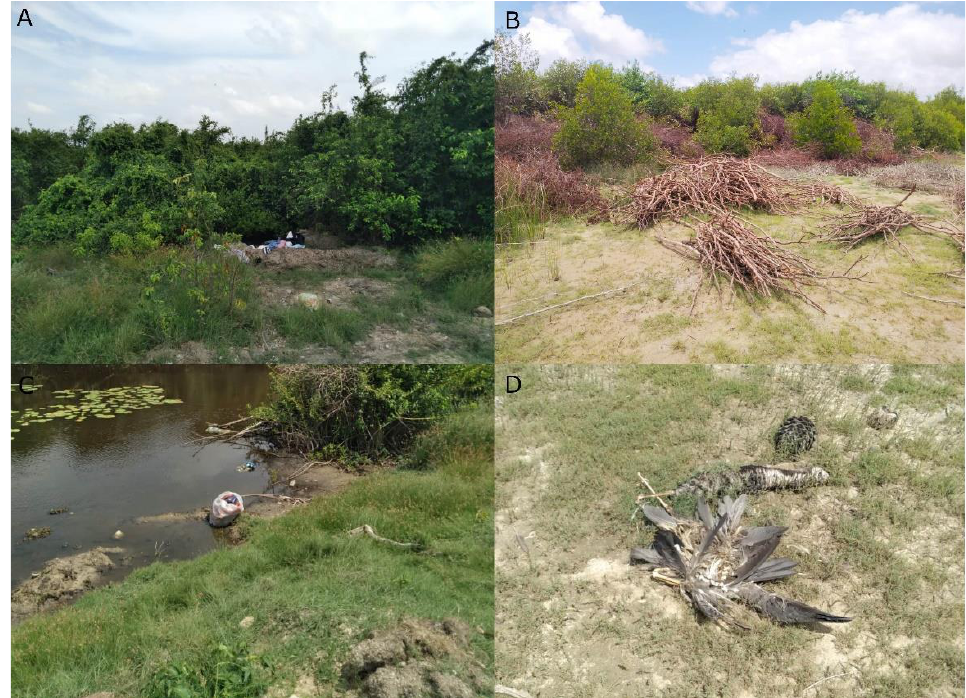
Figure 4. Threats to the Sarasalai mangrove reserve. ( A ) Dumping of garbage; ( B ) cleared mangrove Lumnitzera racemosa ; ( C ) dumping of garbage close to the main road; ( D ) dead bird due to unverified reason.